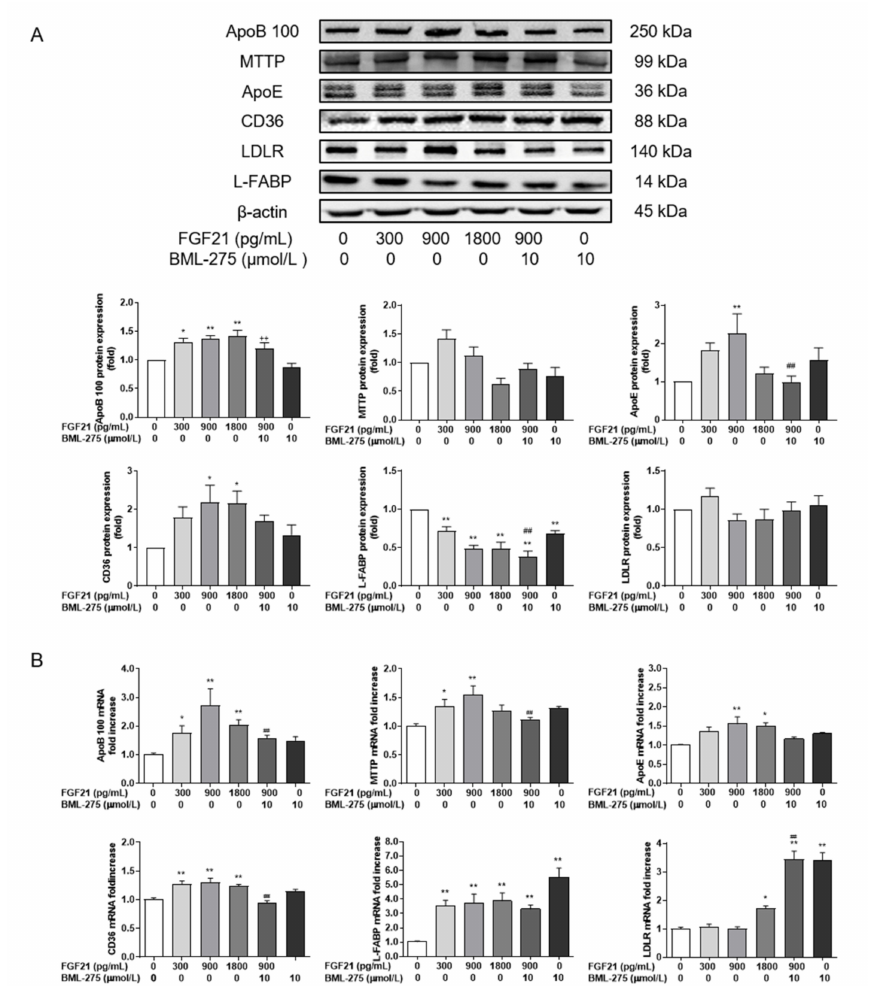
Figure 5. FGF21 promotes lipid transport and increases the secretion of VLDL. Hepatocytes were treated with FGF21 and BML-275 individually or in combination for 4 h. Western blot analysis of ApoB 100, ApoE, MTTP, CD36, LDLR and L-FABP ( A ) and relative mRNA expression levels of ApoB 100, ApoE, MTTP, CD36, LDLR and L-FABP. ( B ). Three independent experiments were performed. Statistical significance was indicated: *, p < 0.05; **, ++ and ## , p < 0.01; * was compared with control group, # was compared with 900 pg/mL group, + was compared with BML-275